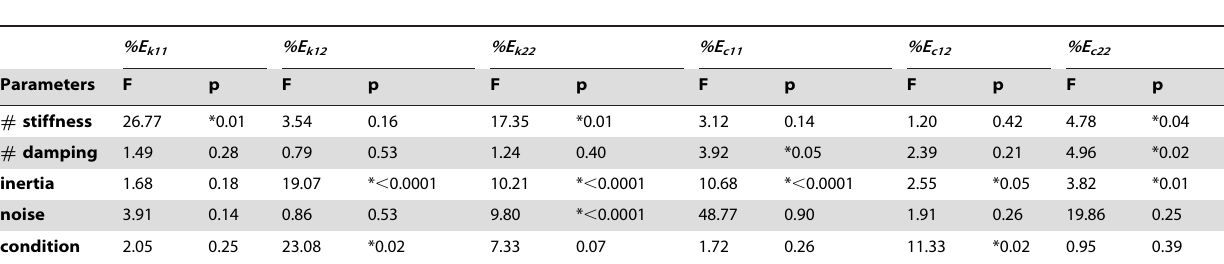
Table 8. Repeated measures ANOVA for the percentage RMS error using displacement full regression among different inertial methods with stiffness and damping time-profiles as random factors along the interval 2.5–5